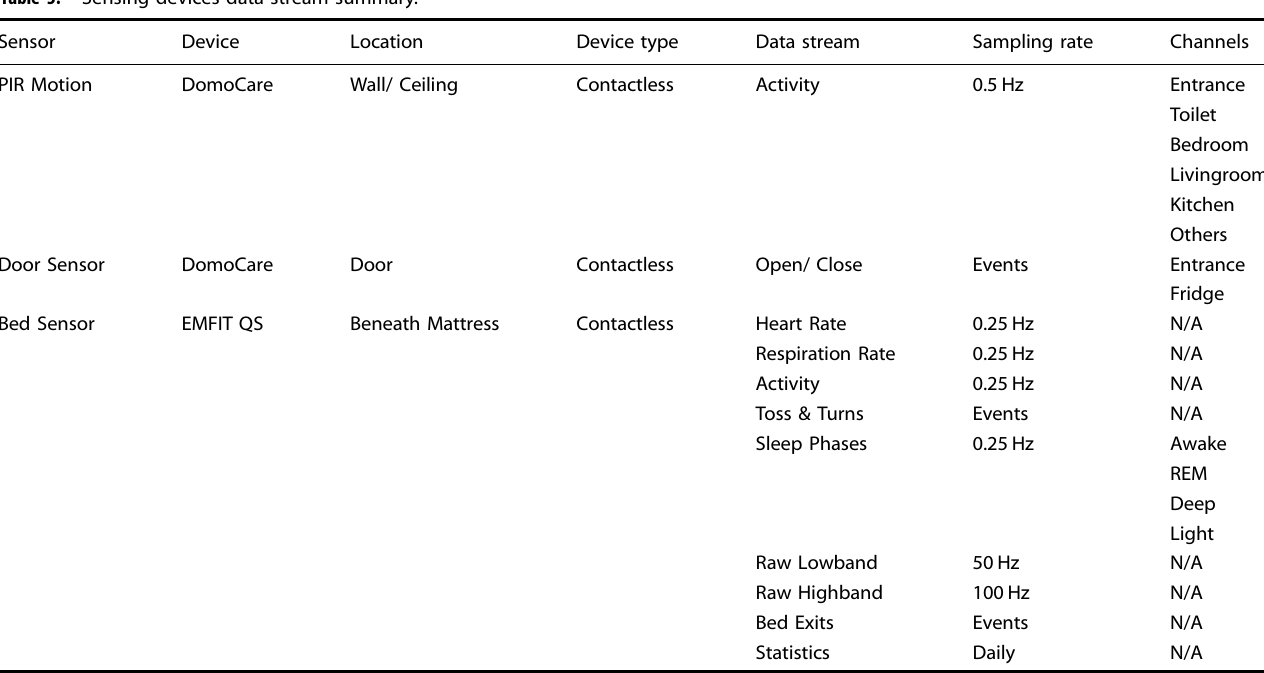
Table 3. Sensing devices data stream